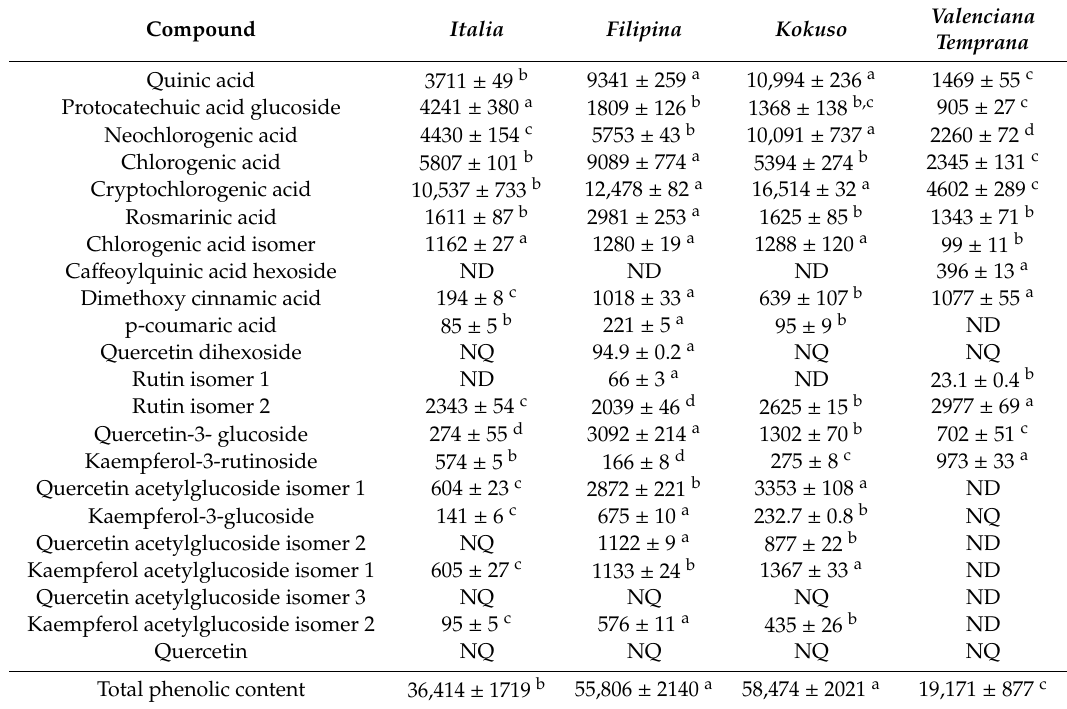
Table 3. Quantification of compounds from di ff erent Morus alba genotypes. Values expressed as µ g of analyte / g of M. alba leaves ±